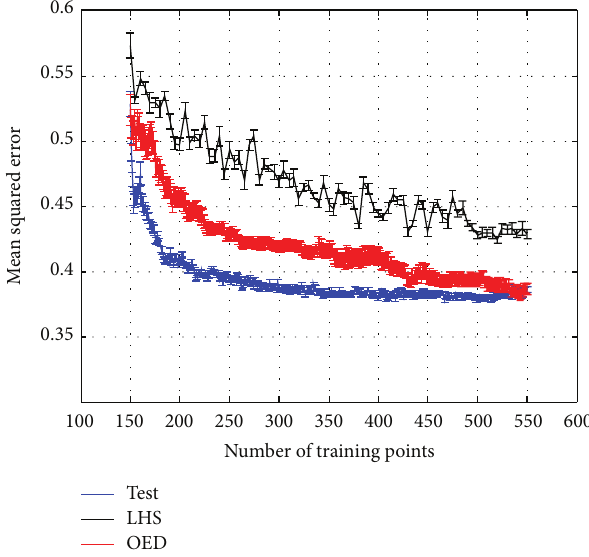
Figure 14: Reduction of mean squared error with increasing number of training points. Bars show standard error.